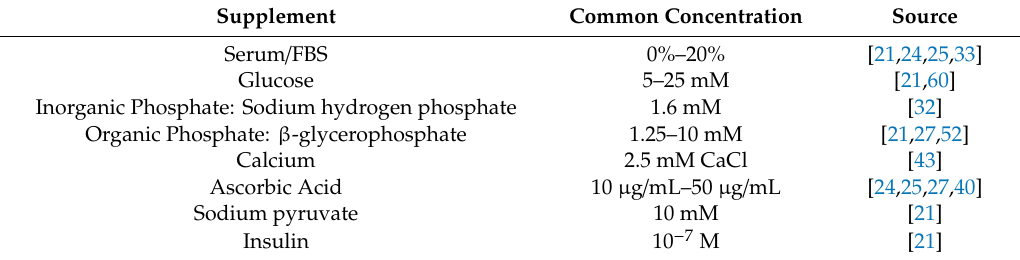
Table 2. Selected supplements and representative dosage for in vitro induction of